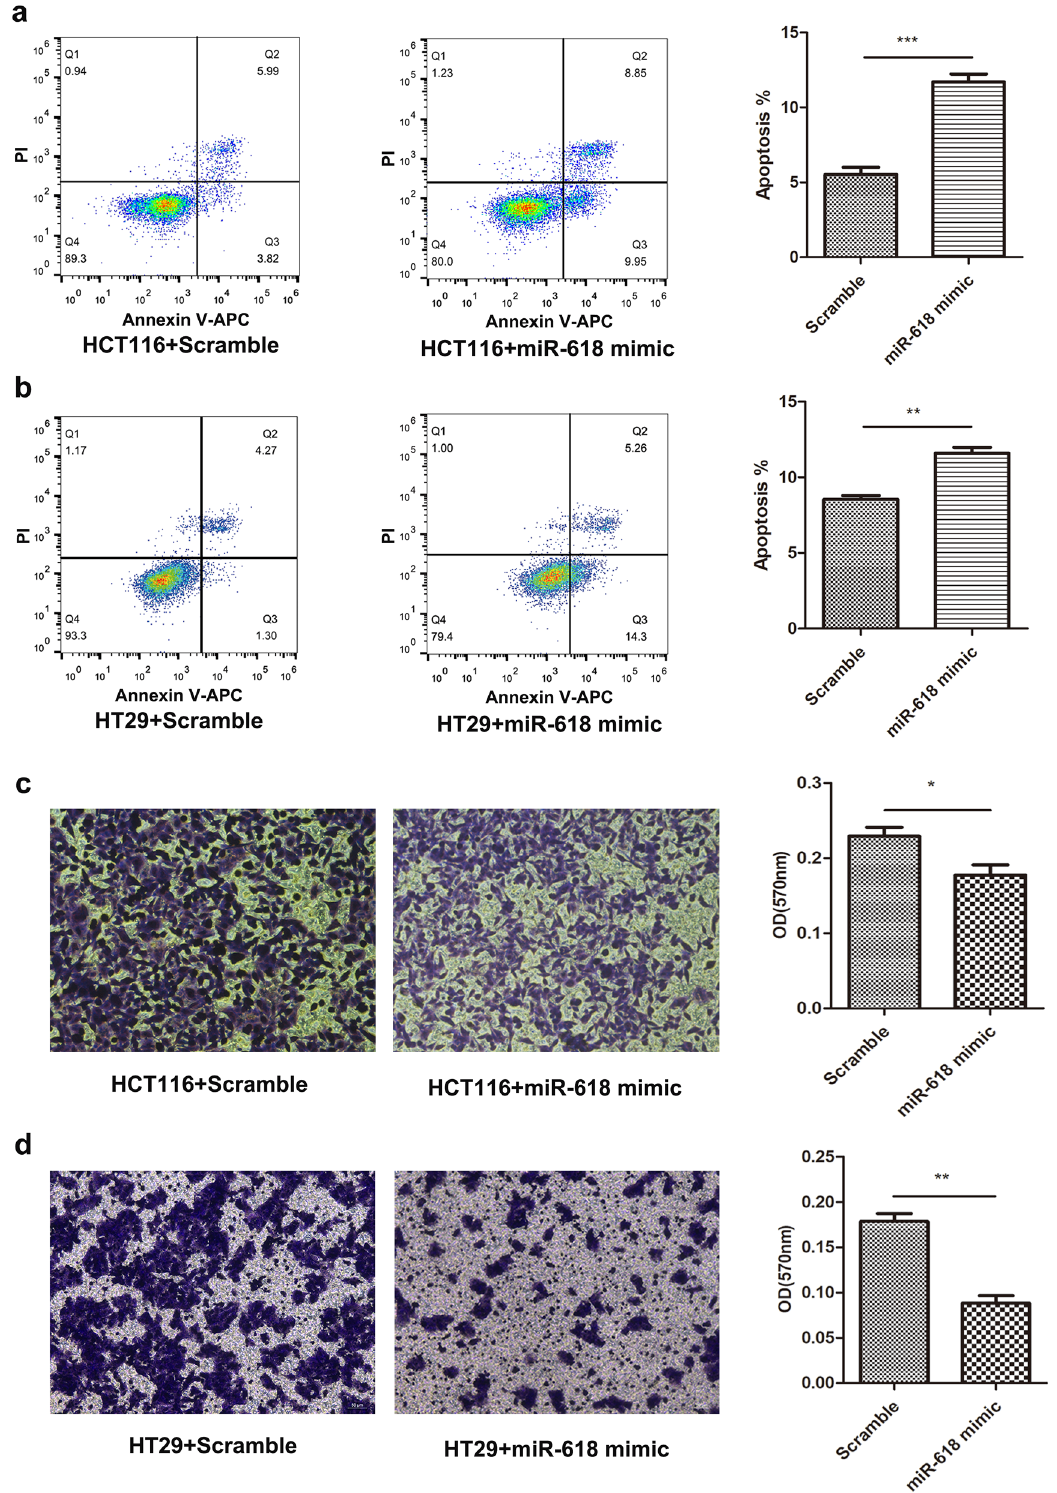
Figure 3. miR-618 inhibits the progression of colon cancer cell lines. ( a ) Flow cytometry analysis of apoptosis of HCT116 cells transfected with miR-618 mimic or Scramble. *** P < 0.001 (t-test). ( b ) Flow cytometry analysis of apoptosis of HT29 cells transfected with miR-618 mimic or Scramble. *** P < 0.001 (t-test). ( c ) Invasion assay of HCT116 cells transfected with miR-618 mimic or Scramble. * P < 0.05 (t-test). ( d ) Invasion assay of HT29 cells transfected with miR-618 mimic or Scramble. ** P < 0.01